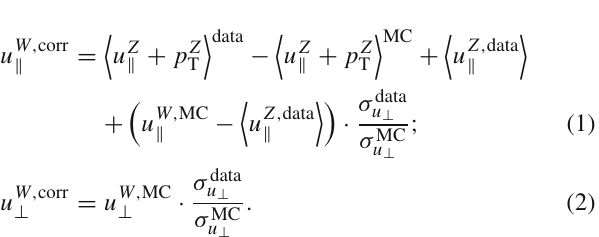
Fig. 3 Distributions of a u (cid:8) + p Z and b u ⊥ in data and T Z → μ + μ − MC simulation before (squares) and after (circles) recoil calibration. The shaded band in the ratio panels represents the statistical uncertainty of the data sample, while the error bars represent the systematic uncertainty associated with the calibration